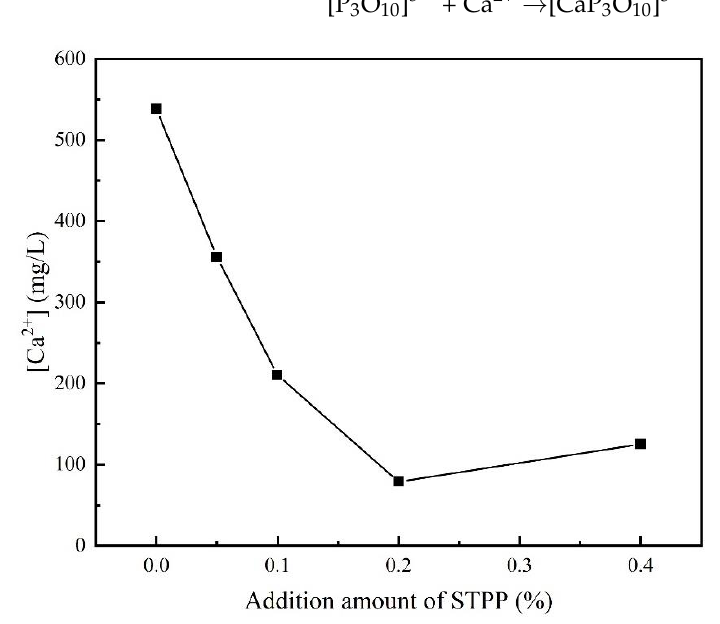
Figure 3. Effect of STPP addition on Ca 2+ concentration in the filtrate after 10 min of stirring.